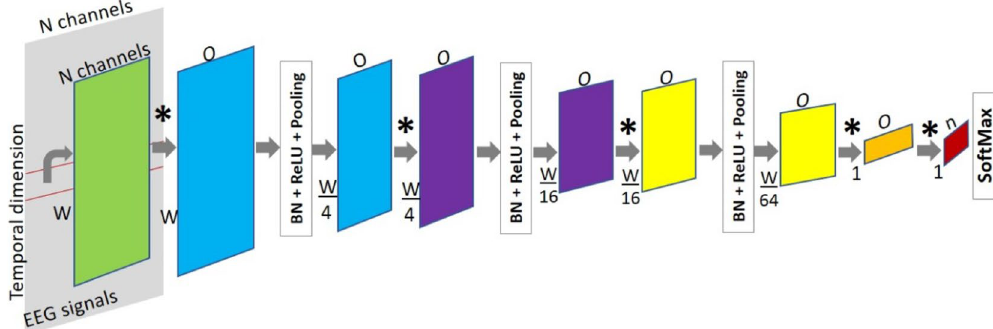
Figure 11. Proposed FCN architecture for the automated classification of EEG recordings into ictal and interictal states. The temporal dimension is reduced by 4 × at every block (blue, purple and yellow). *A convolution operation, n is the number of classes, W is the window width, and O is the number of output channels in the respective convolutional